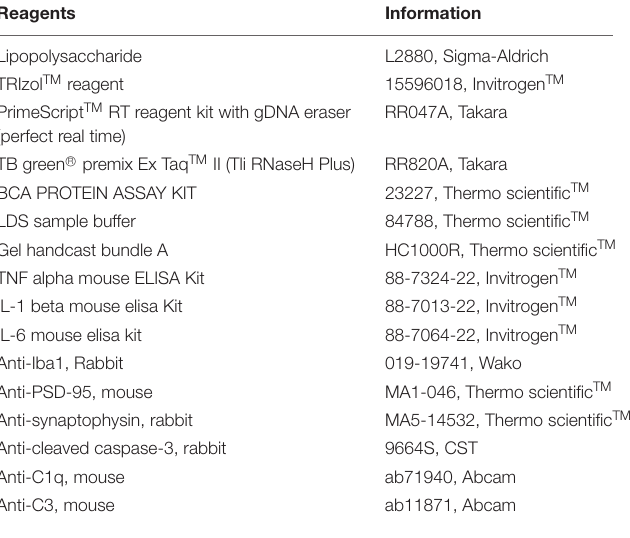
TABLE 1 | List of laboratory